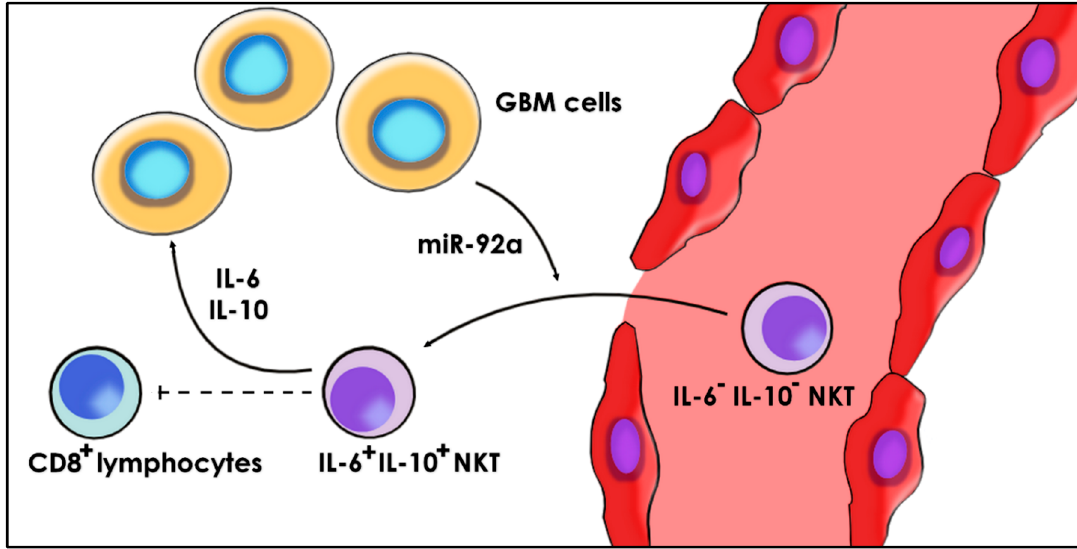
Figure 7. Natural killer T cells (NKT) differentiation and roles of the immunotolerant NKT in glioblastoma maintenance and immune evasion (arrows—activation; dotted T-bars—inhibitory effect).